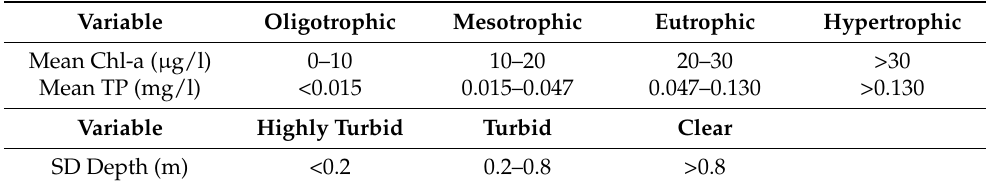
Table 2. Trophic status indicators and the appropriate ranges used to classify